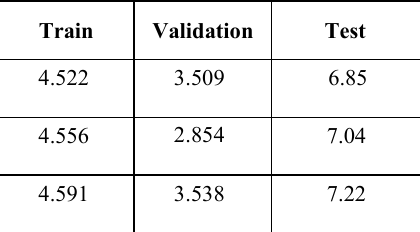
Table 1. Best Overall Train, Validation and test report